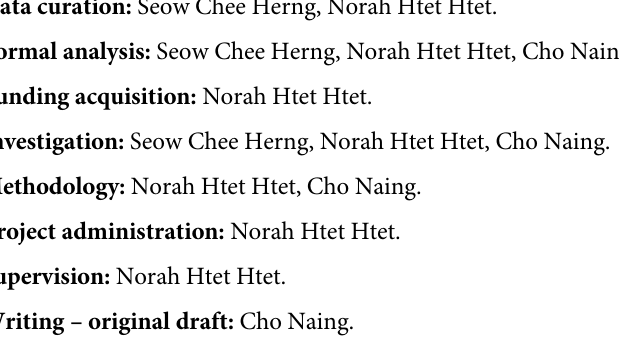
S1 Table. Summary of the excluded studies. S2 Table. Direct and indirect estimates. S1 Fig. Methodological quality assessment. S2 Fig. Forest plot for neoadjuvant